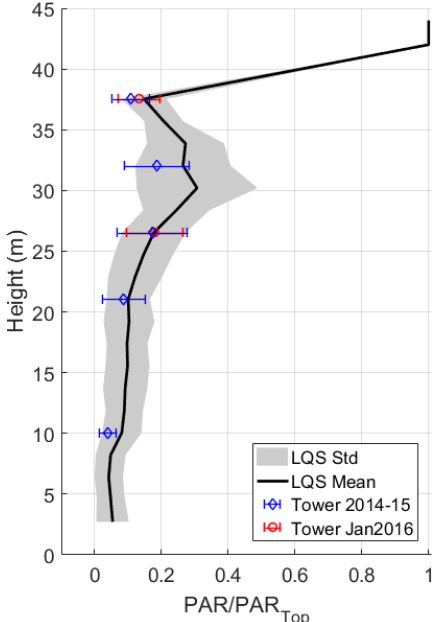
Figure A4. The PAR / PAR Top profile is measured based on Eq. (A2). Tower 2014–15 indicates measured data at the tower from 2014 to 2015. Tower Jan2016 indicates measured data at the same time with LQS